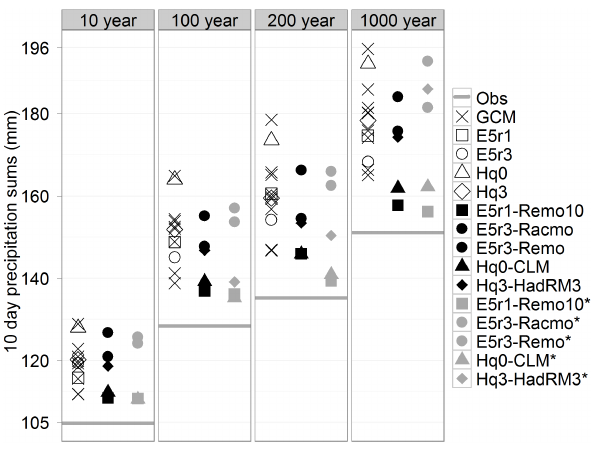
Fig. 6. Ranges of return levels of 10-day basin-average precipitation for four return periods for the future climate (end of 21st century). The results are shown for the transformed observations based on the RCM and GCM ensembles and for the bias-corrected RCM output from the RheinBlick2050 project. All GCM results are plotted in the first column of symbols. Open symbols represent GCM simula- tions that force at least one RCM; crosses refer to the results from the other GCM simulations. The second column represents trans- formed observations based on RCM simulations while the third col- umn refers to the bias-corrected RCM output. The RCMs are indi- cated by the same symbol as used for the driving GCM (in the first column). The grey horizontal lines denote the return levels of the 10-day basin-average precipitation from the reference observations (i.e. the current